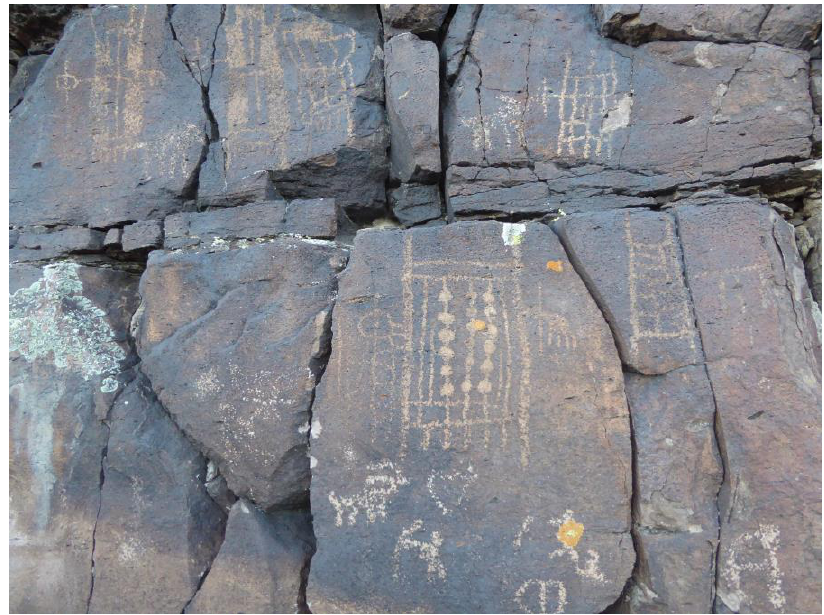
Figure 10. Peckings of transformed shaman (Source: Stoffle).